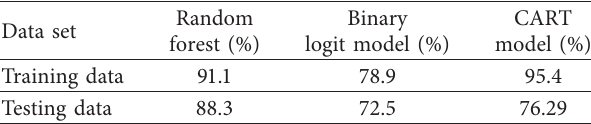
Table 8: Prediction results and comparison of models. Data